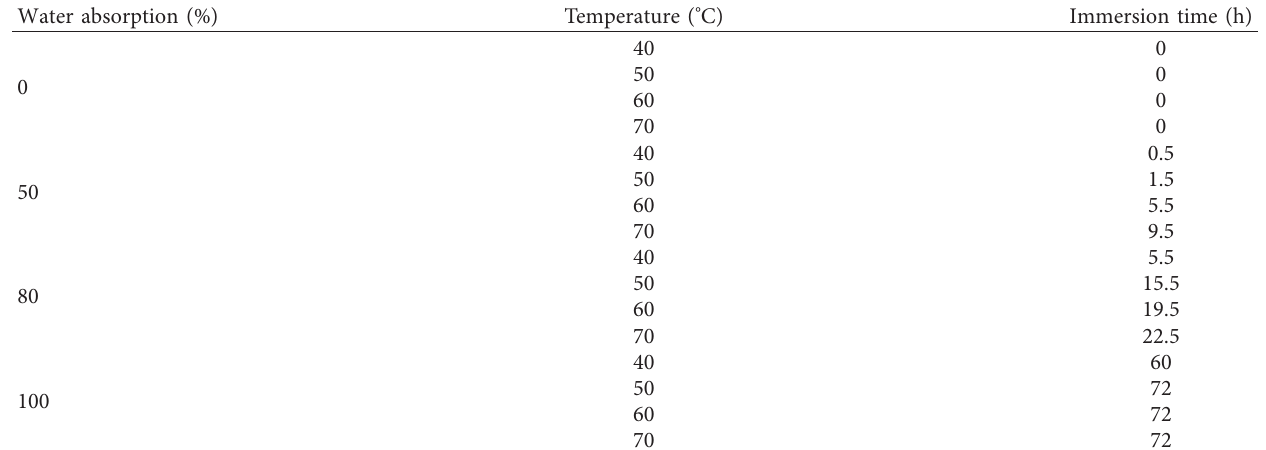
Table 8: Time index of moisture content of asphalt concrete under AC-13 grading.